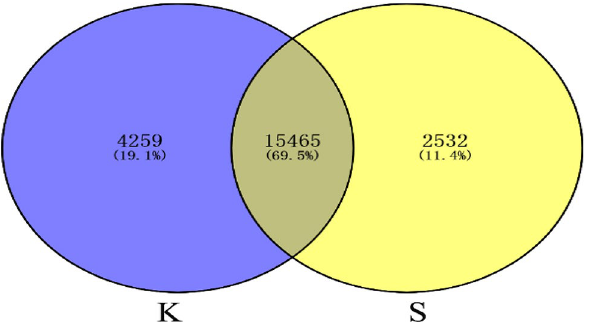
Figure 3. The number of expressed genes between two libraries. Venn diagram showing the number of reference genes specifically expressed in one library and those expressed in Kazakh sheep library (K) and Suffolk sheep library (S).